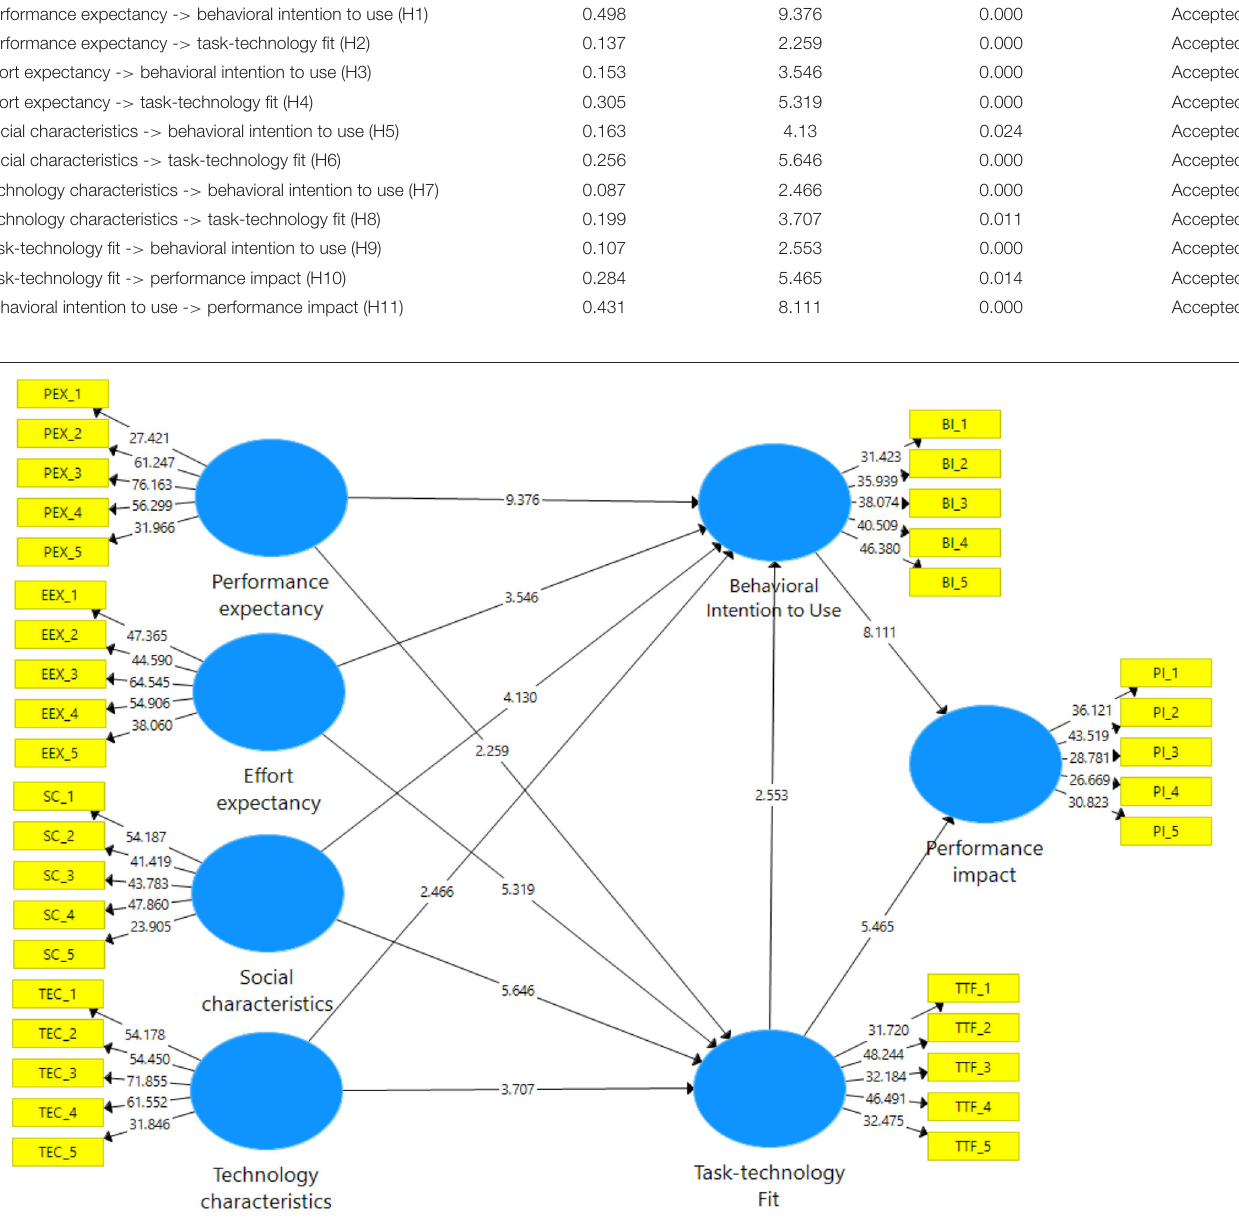
FIGURE 3 | Path t -value